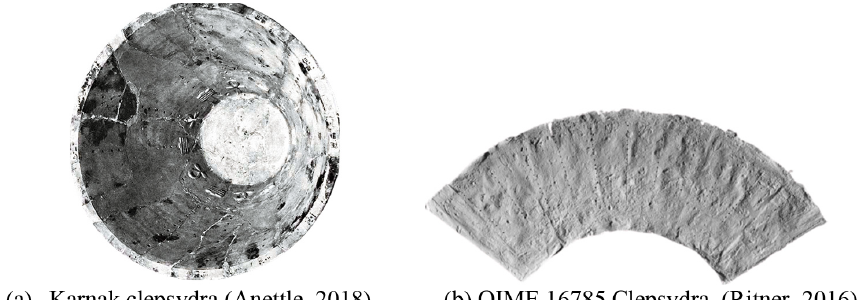
Figure 3. Clepsydra with notch lines showing the regulation flow.